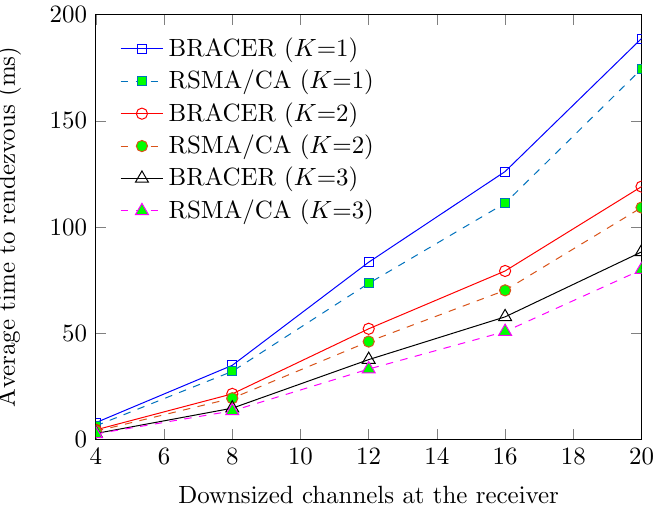
Figure 8. Average TTR vs. Y at the receiver (for various K s).